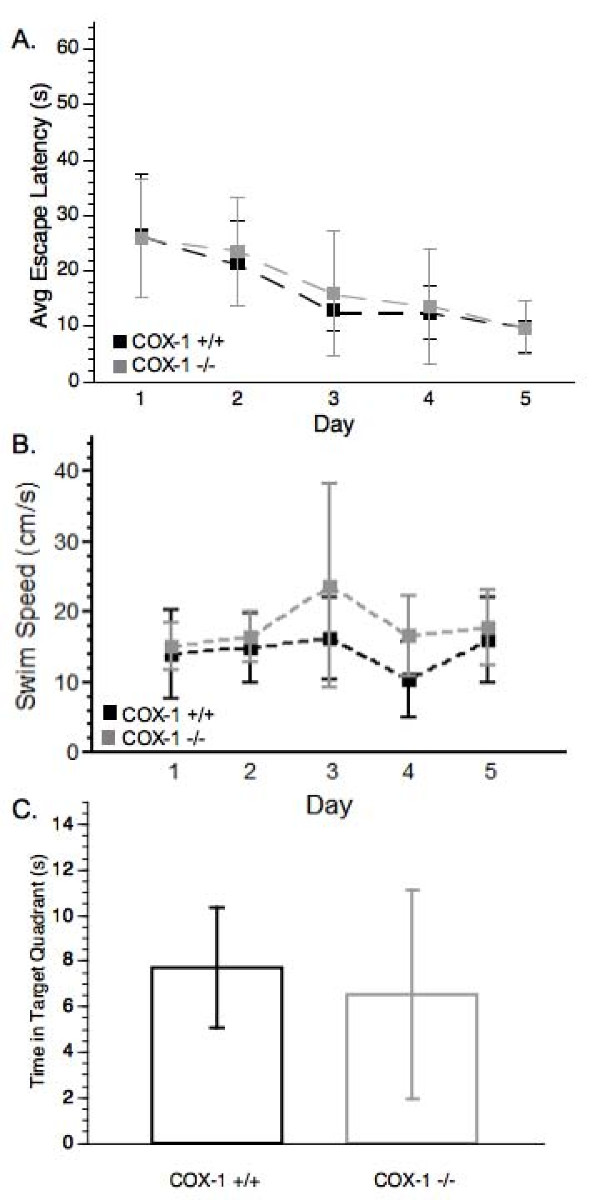
Post-injury cognitive assessment and probe trial of COX-1 +/+ and COX-1 -/- mice. (A) Post-injury MWM escape latency. There was a significant effect of day (ANOVA P < 0.0001) for both genotypes, but there was no significant difference between COX-1 +/+ and COX-1 -/- mice. (B) Analysis of swim speed during the probe trial of the MWM. (C) Duration of time mice remained in the target quadrant during the probe trial of the MWM. Data are presented as mean ± SD.